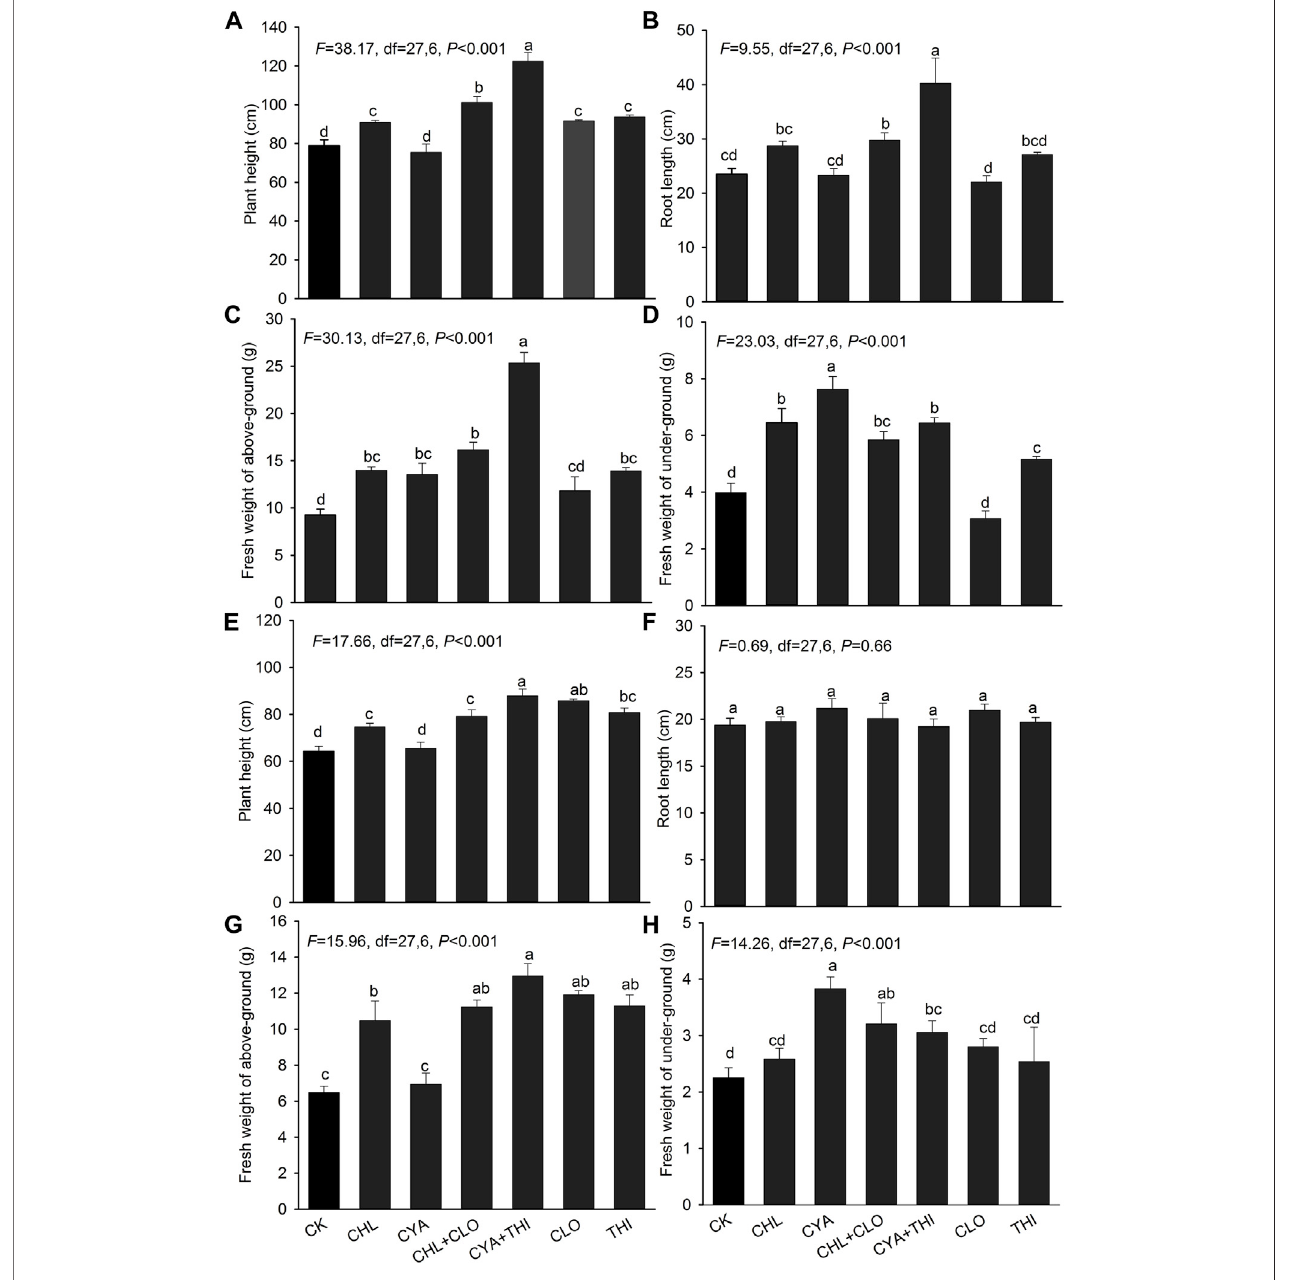
FIGURE4| The meanplant height,root length,and fresh weight above-ground and underground ofcorn seedlingstreatedwithCHL, CYA,CLO, THI,CHL+CLO and CYA + THI in the July (A – D) and September (E – H) of2021. Columns labeled withthe sameletter werenot signi fi cantlydifferent using Tukey ’ sHSD test at p < 0.05.